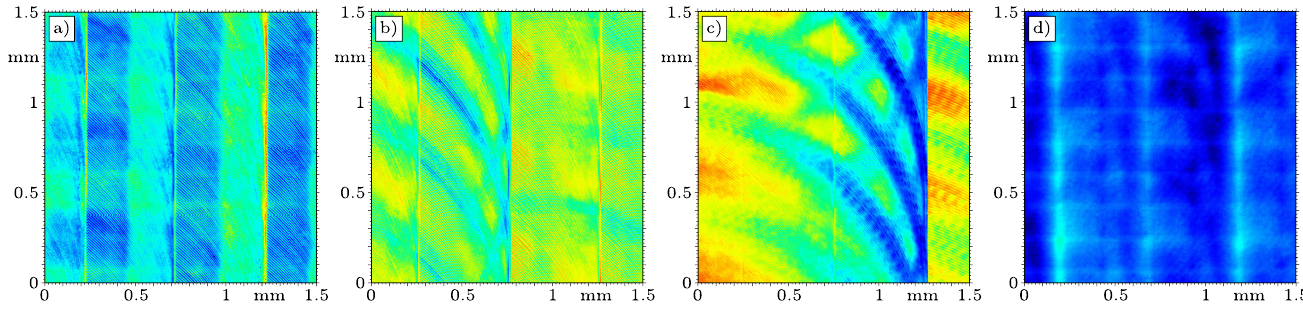
Figure 6. Surface structure of surfaces generated with ( a ) F0.1 R0.05-R50 ( v c = 250m/min, f z = 0.015mm, a p = 0.25mm, a e =